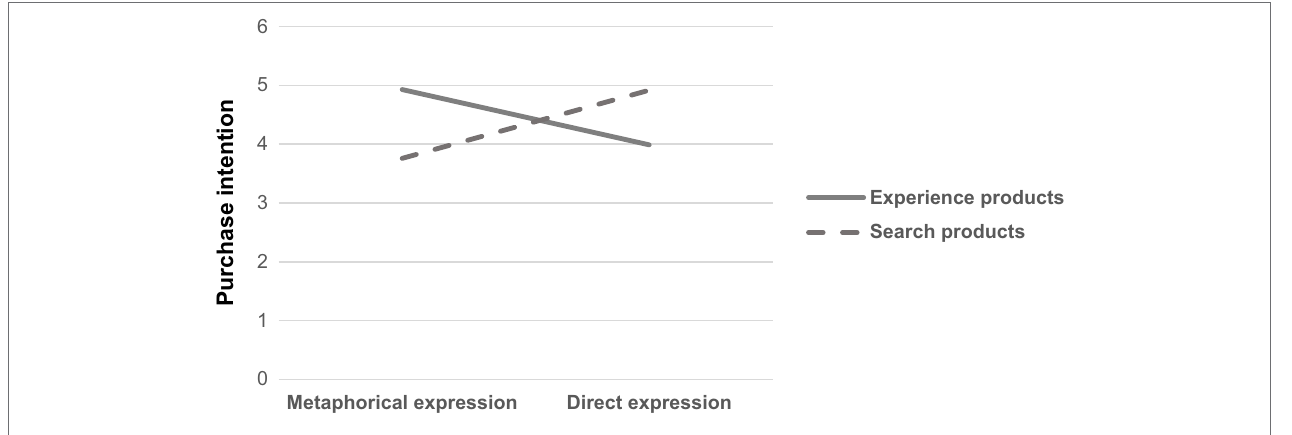
FIGURE 1 | The combined effect of product types and expressions of advertised information on consumers’ purchase